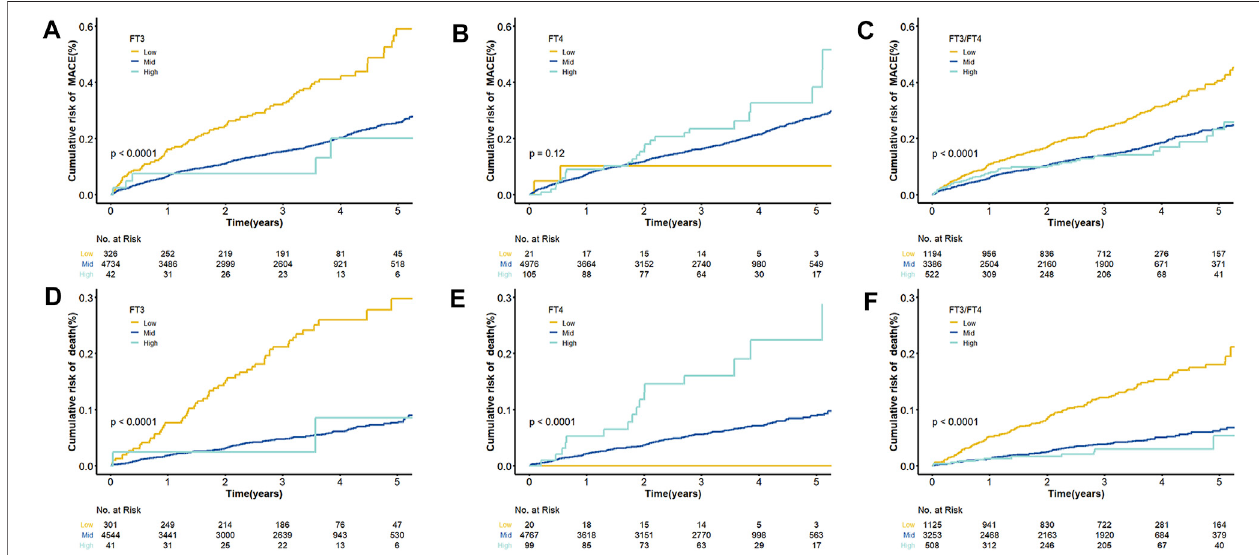
FIGURE2| CumulativeKaplan – MeierCurvesforFT3,FT4andtheratioofFT3andFT4. (A) CumulativeKaplan – MeierCurvesforMACEaccordingtoFT3quartiles; (B) Cumulative Kaplan – Meier Curves for MACE according to FT4 quartiles; (C) Cumulative Kaplan – Meier Curves for MACE according to FT3/FT4 quartiles; (D) Cumulative Kaplan – Meier Curves for death according to FT3 quartiles; (E) Cumulative Kaplan – Meier Curves for death according to FT4 quartiles; (F) Cumulative Kaplan – Meier Curves for death according to FT3/FT4 quartiles.